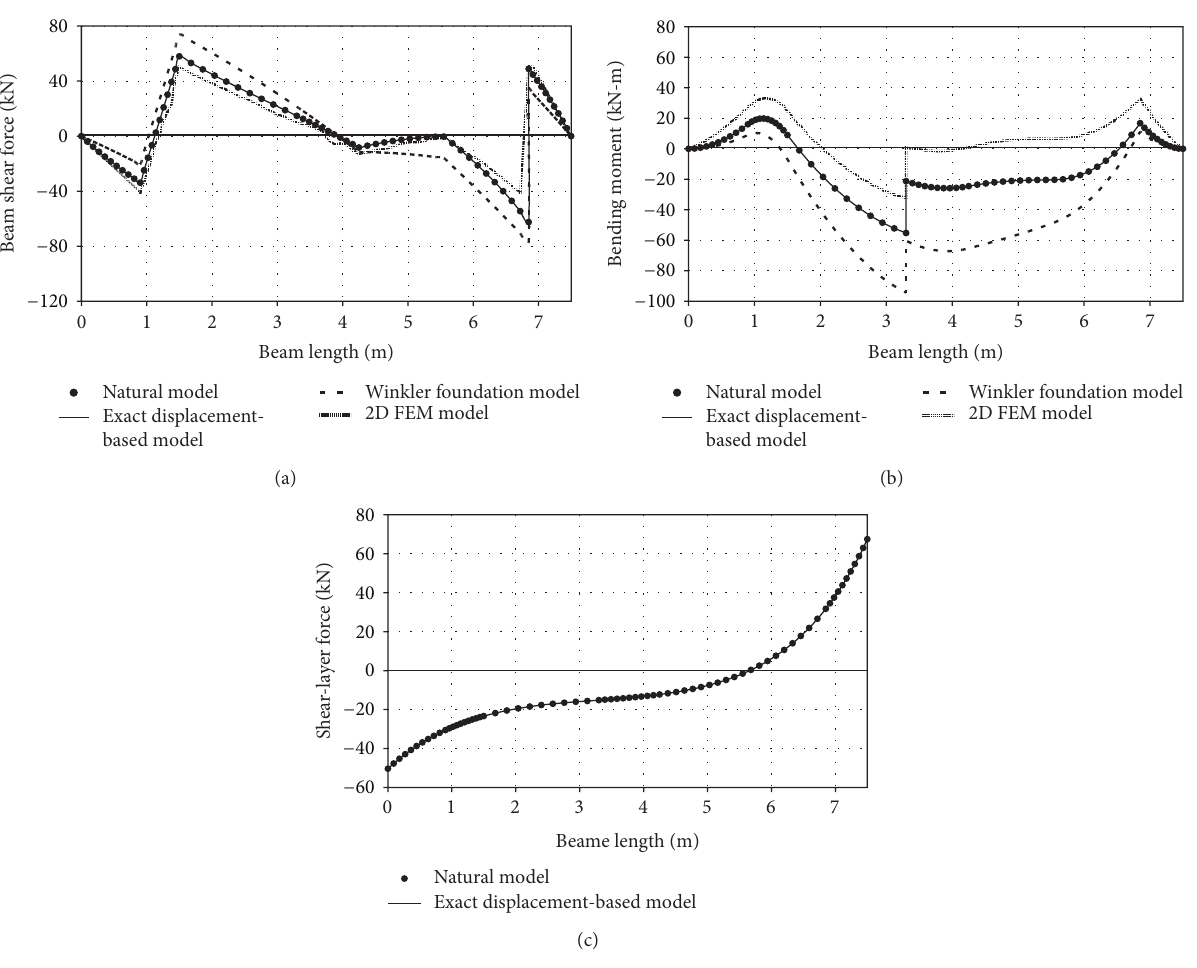
Figure 6: Diagrams for beam shear force, bending moment, and shear-layer force.